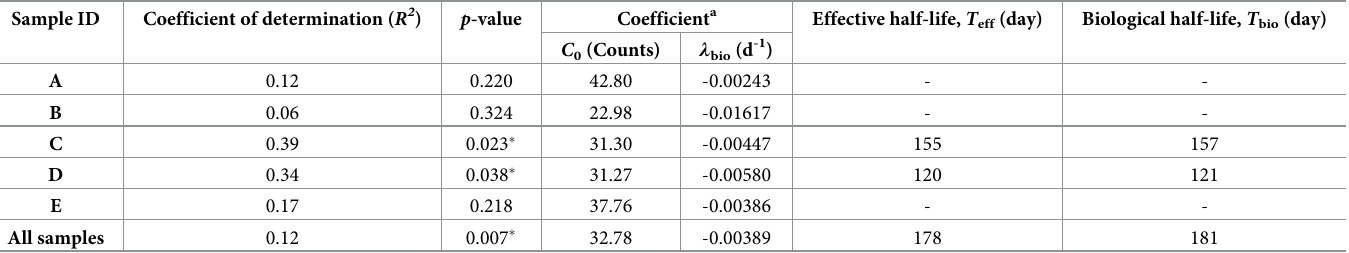
Table 1. Summary statistics for the regression slopes of the 137 Cs radioactivity (total number of 137 Cs counts), effective half-life ( T eff , day), and biological half-life ( T b , day) of all 5